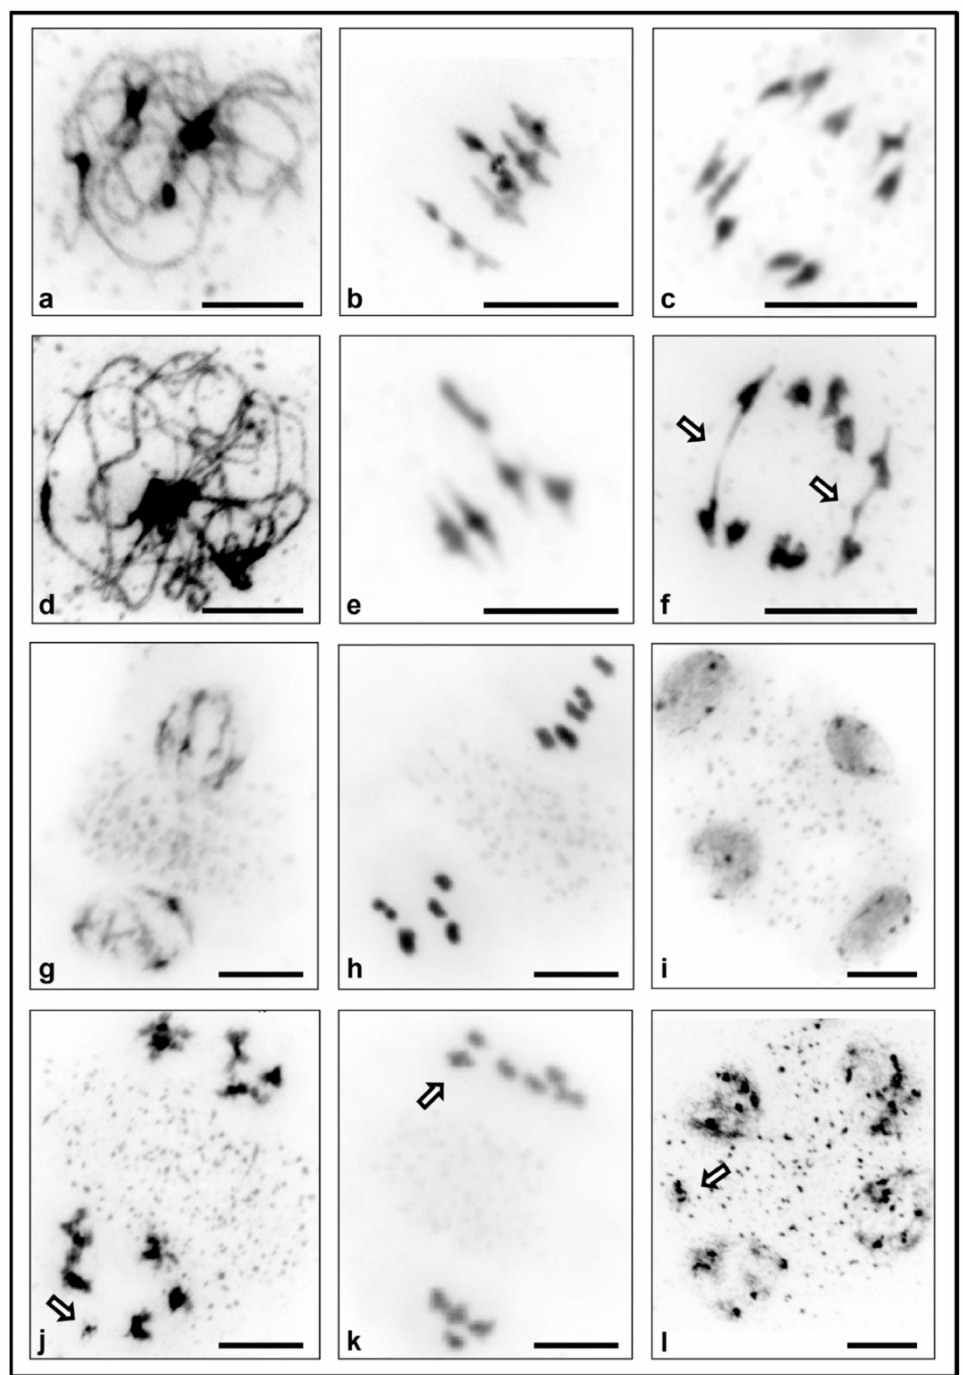
Figure 2. Meiotic stages in the WT and the topbp1 mutant. ( a – c , g – i ) Images of PMCs at different stages in the WT ( d – f , j – l ) and in the topbp1 mutant. ( a , d ) Pachytene stage, ( b , e ) metaphase I, ( c , f ) anaphase I, ( g , j ) prophase II, ( h , k ) metaphase II, and ( i , l ) telophase II/tetrad. Arrows indicate errors in meiotic divisions: ( f ) anaphase I bridge, ( j ) chromosome fragments, ( k ) chromosome mis-segregation, and ( l ) micronuclei. Scale bar 10 µ